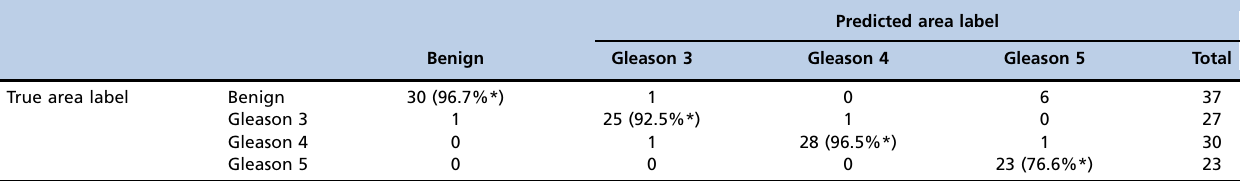
Table 3 - Scanning classification method—true area label (pathologist analysis) versus deep learning predicted area label in test dataset images.